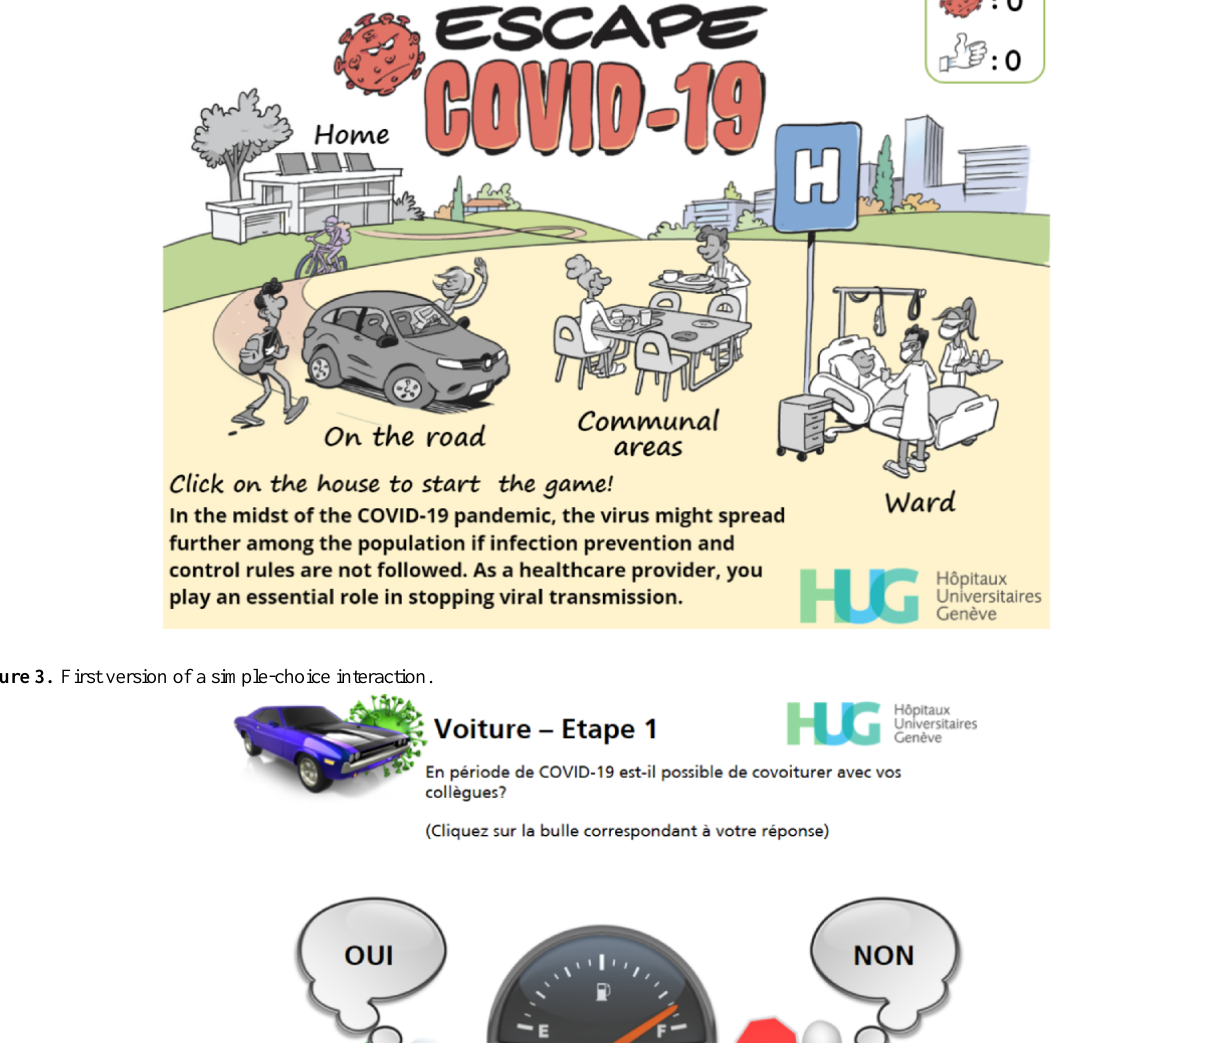
Figure 2. Final version of the welcome screen.